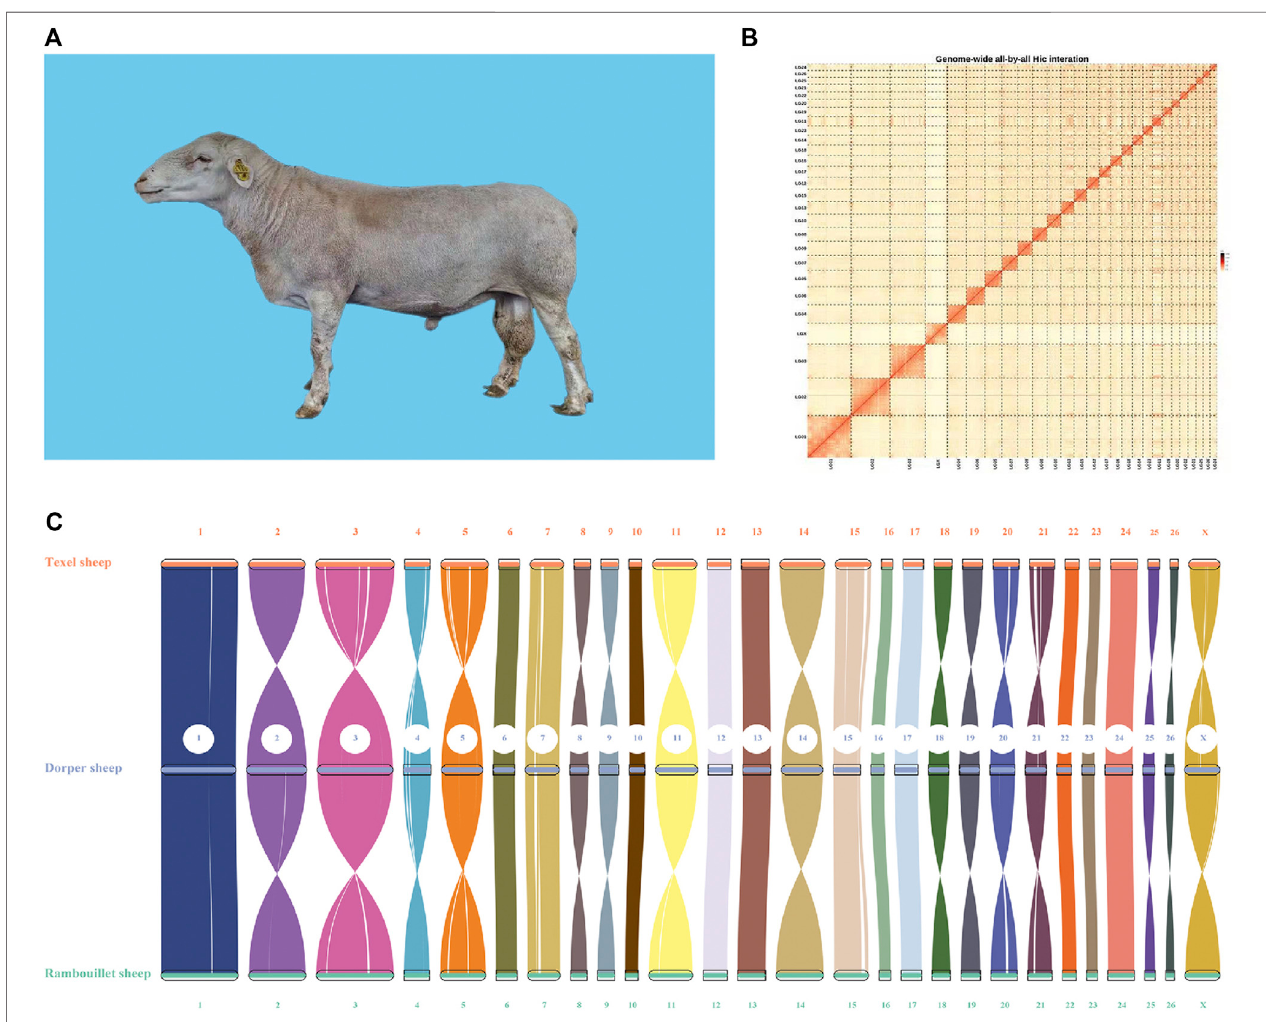
FIGURE 1 | Image and genome quality of Dorper sheep. (A) Image of Dorper Sheep. (B) Genome-wide all-by-all Hi – C interaction. (C) Syntenic analysis of assembled genome.